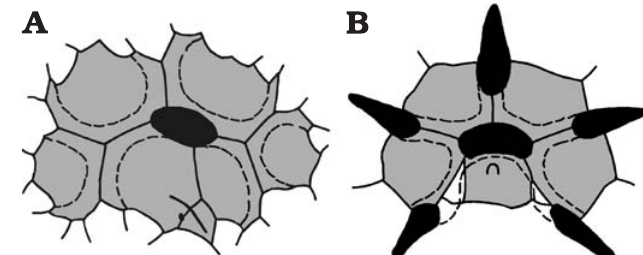
Fig. 3. Line drawings showing oral regions of the derived blastozoan, Glyptocystella loeblichi ( A ) and crinoid, Hybocrinus nitidus , five wedge- shaped coelomic slots, and madreporic hydropore (inverted U below peri- stomial opening) ( B ). Modified from Sprinkle (1982a,